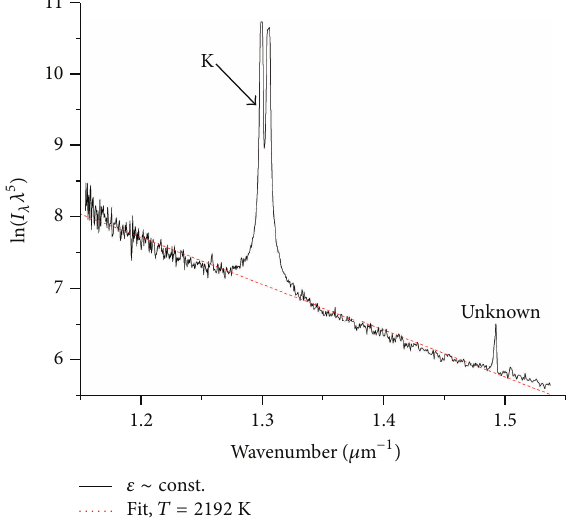
Figure 11: Fit of the thermal background from the Jaz spectrometer to determine